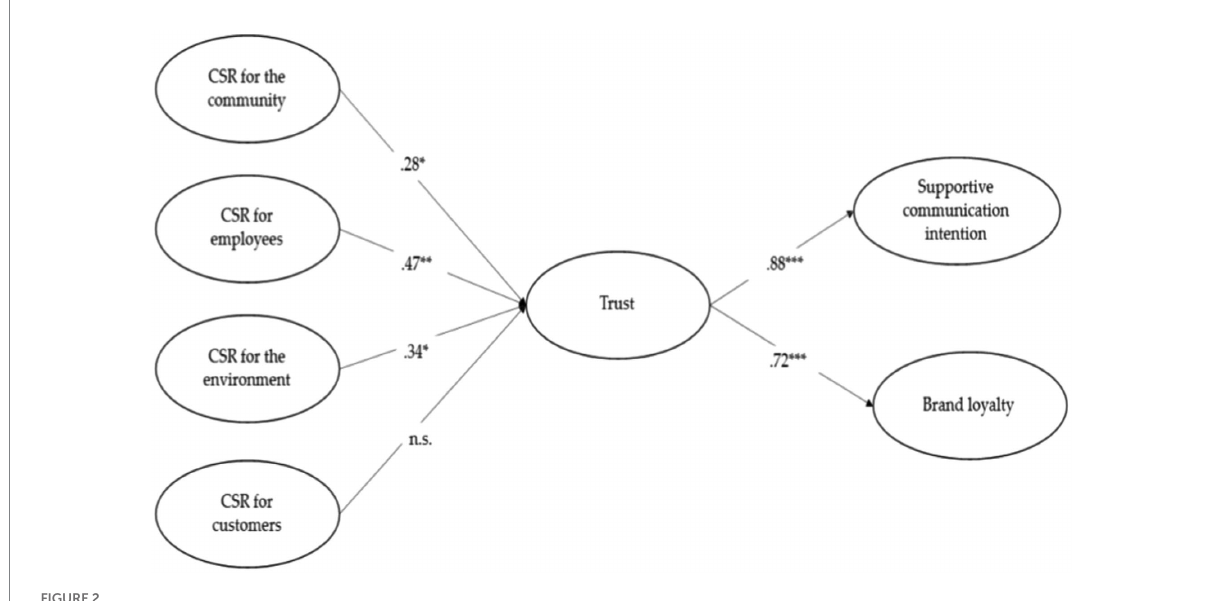
FIGURE 2 The results of the model.